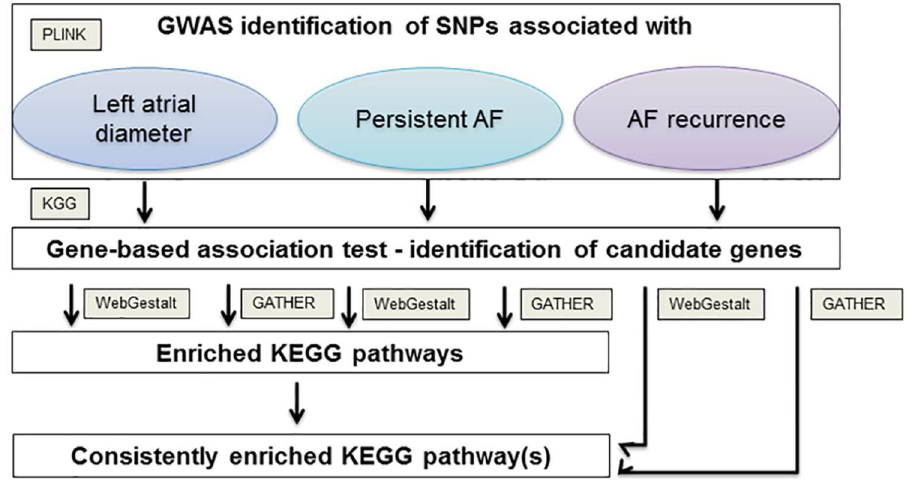
Fig 1. Flow chart of pathway enrichment analysis based on GWAS of LAD, AF type and AF recurrence after catheterablation.